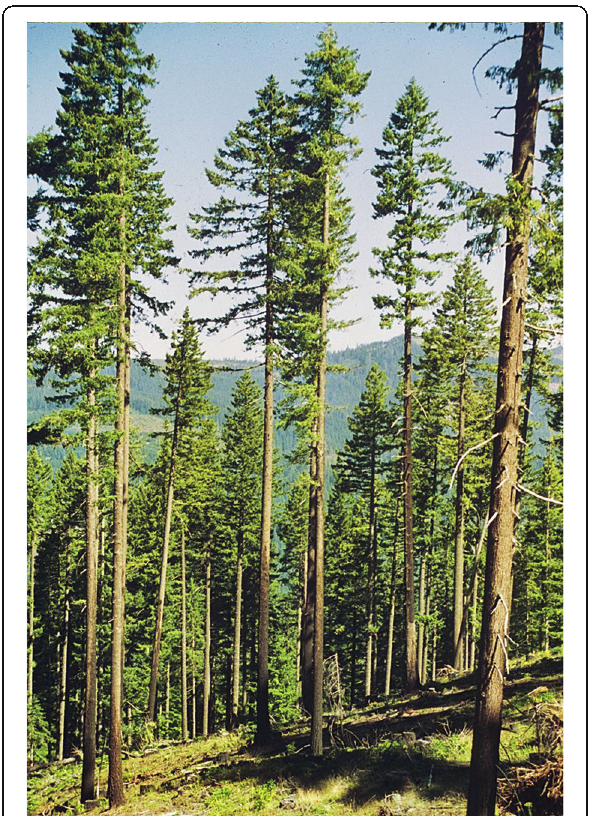
Fig. 2 The first retention harvest conducted by the senior author on the Willamette National Forest, Oregon; the prescription was for 15% retention of live basal area in sound dominant and co-dominant mature Douglas-fir distributed uniformly over the harvested site. This selection of retained trees was done with the goal of both high levels of survival and availability of high-quality trees for harvest during the next harvest